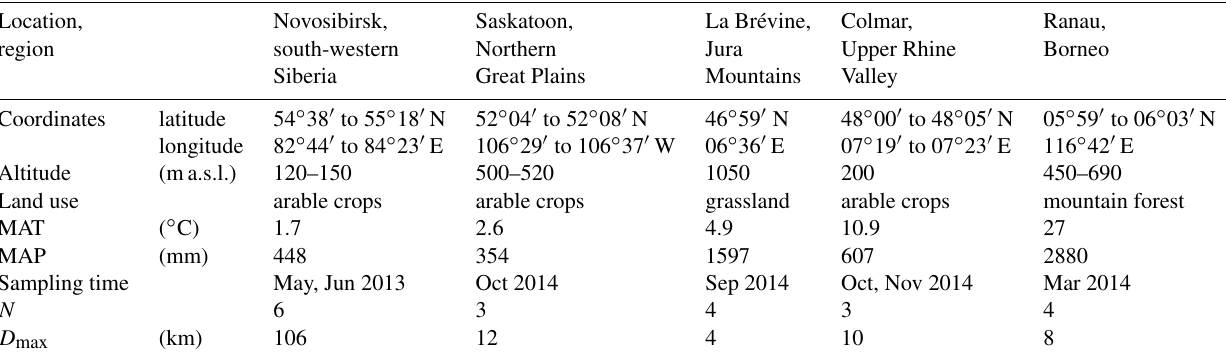
Table 1. Details of sample origin, including mean annual temperature (MAT) and precipitation (MAP). In each area, between three and six samples ( N ) were collected. A sample consisted of 100 to 300g of soil collected from the surface within a radius of a few metres. The maximum distance between samples ( D max ) ranged from 4 to